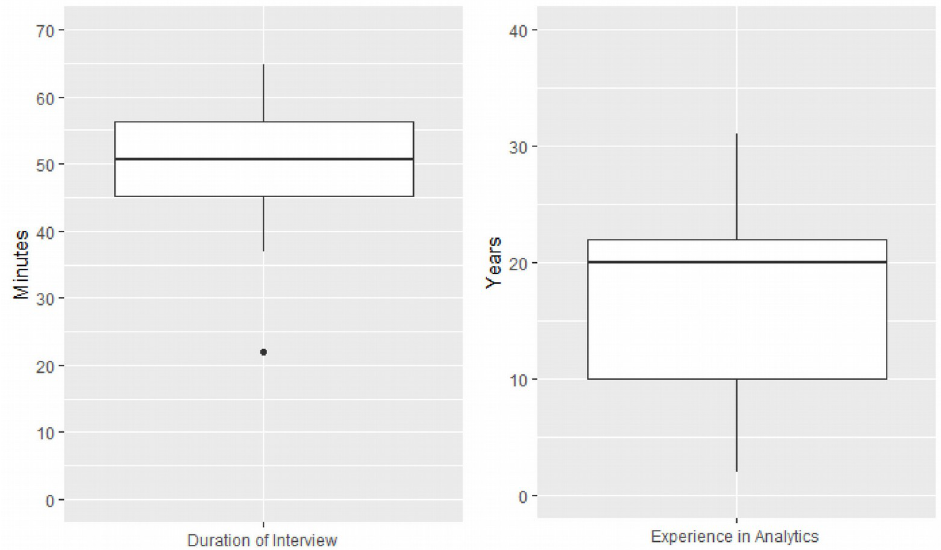
Figure 1. (left) Duration of Interviews with Experts, (right) Experts Experience in